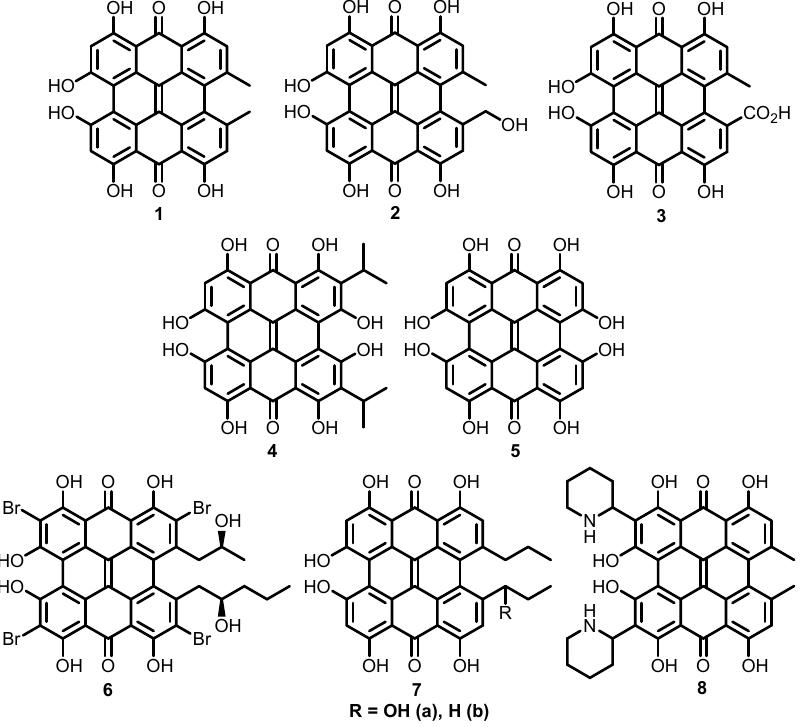
Figure 2. Natural naphtodianthrones.